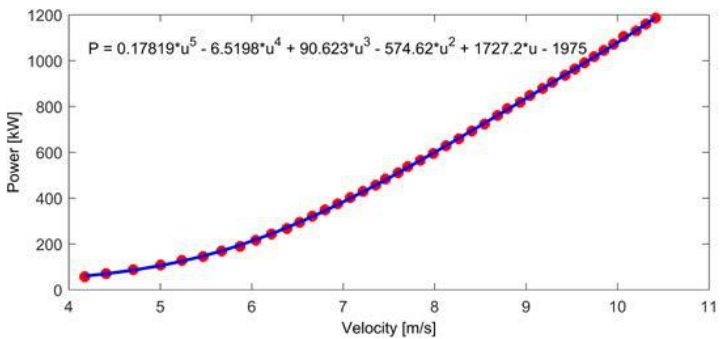
Figure 2. Power curve of the V-80 wind turbine. Red circles correspond to the manufacturer’s data and the blue line represents a polynomial fit.